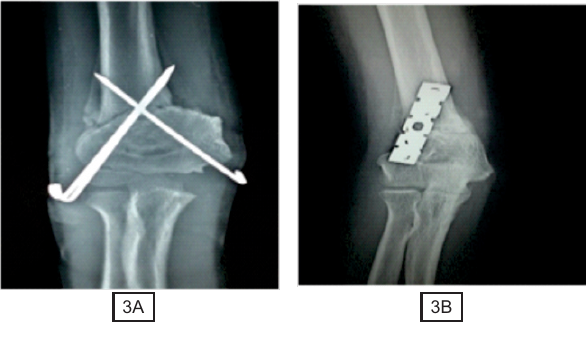
Figure 3 (A, B): The osteotomy was xed with cross k- wires and and plate and